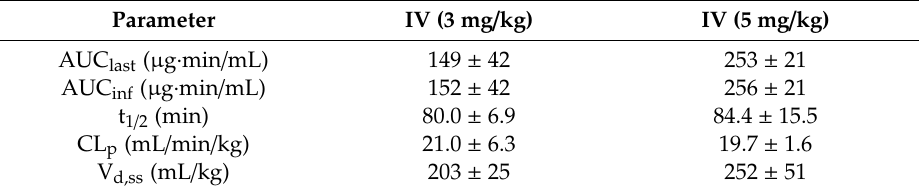
Table 4. Pharmacokinetic parameters of ECN after intravenous (IV) administration in rats.